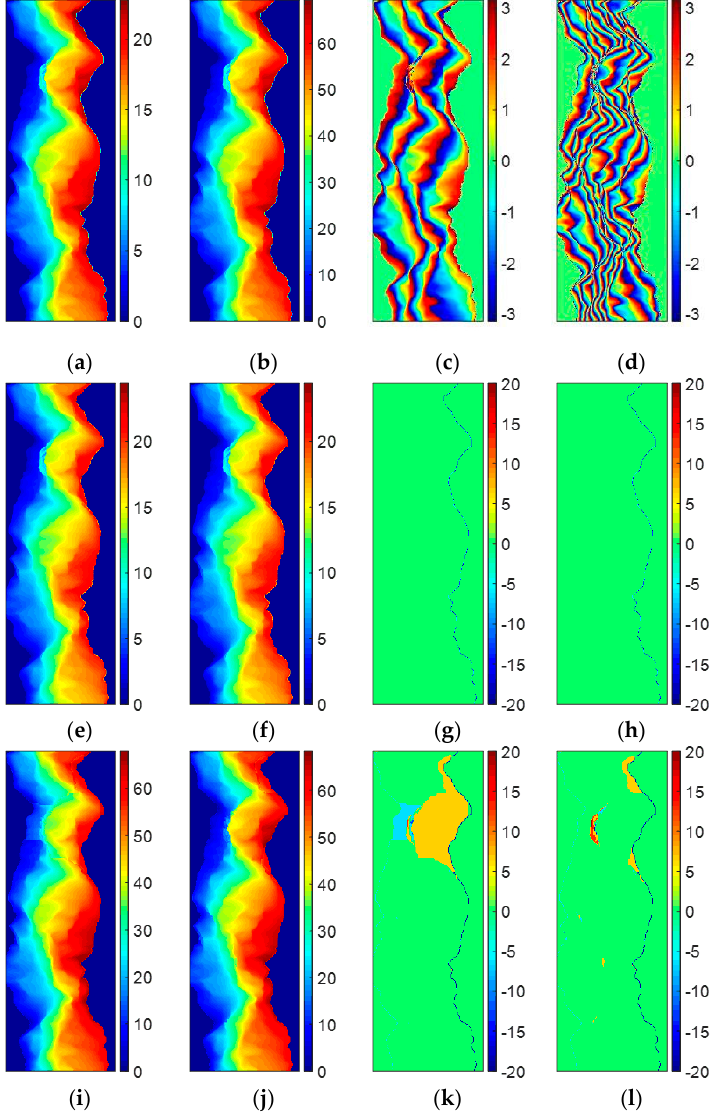
Figure 1. ( a , b ) Reference unwrapped phases (( a ) short and ( b ) long baseline length). ( c , d ) Simulated wrapped phases of ( a , b ). ( e , f ) PU results of ( c ) obtained by ( e ) PUMA (clique potential exponent is 1), and ( f ) PUMA (clique potential exponent is 0.5). ( g , h ) Errors between ( a ) and PU results ( e , f ). ( i , j ) PU results of ( d ) obtained by ( i ) PUMA (clique potential exponent is 1), and ( j ) PUMA (clique potential exponent is 0.5). ( k , l ) Errors between ( b ) and PU results ( i , j ).